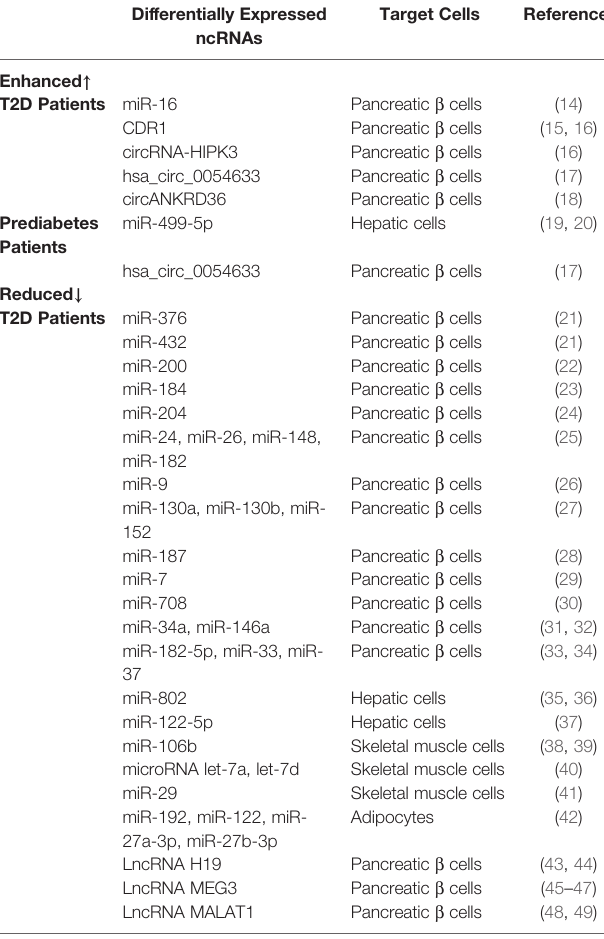
TABLE 1 | Summary of different expressions of ncRNAs in various target cells of T2D and prediabetic patients. Differentially Expressed